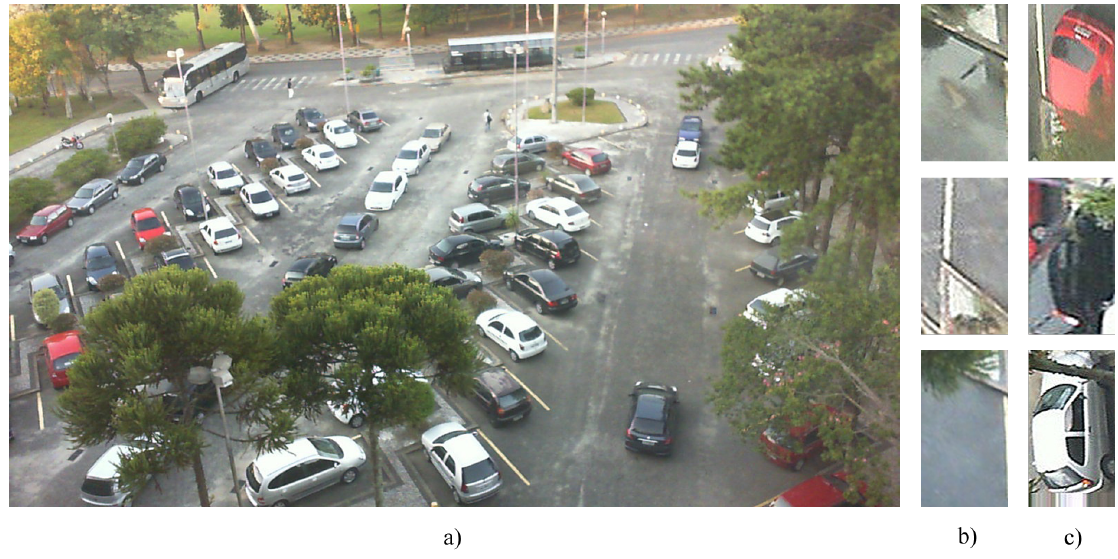
Figure 2. ( a ) example of a parking lot in PKLot dataset [4]; ( b ) example images of empty parking spaces after cropping and rotating; ( c ) example images of occupied parking spaces after cropping and